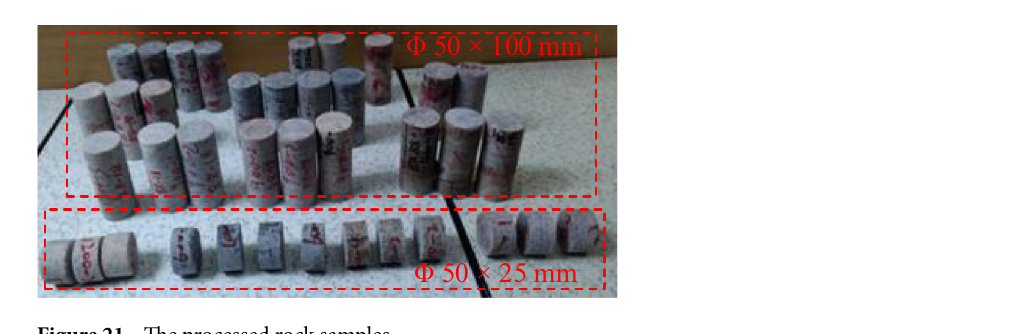
Figure 20. The rockburst site in Sanshandao Gold Mine 62 .